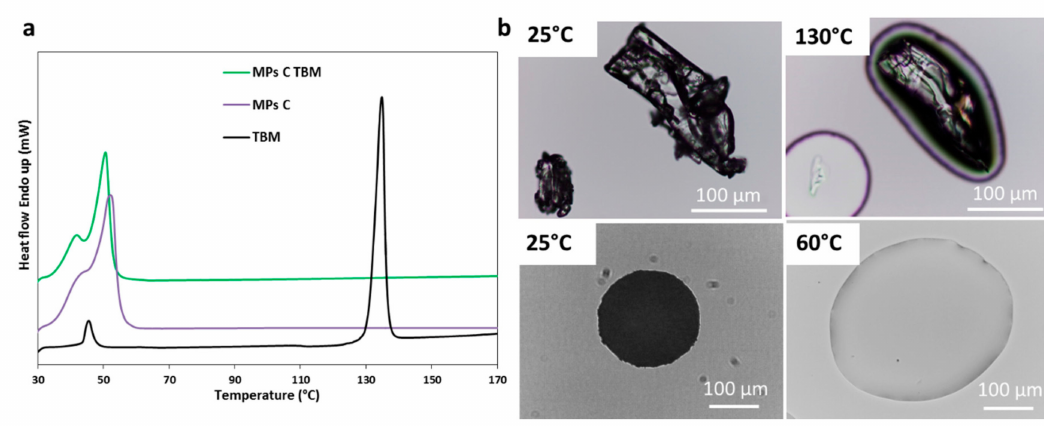
Figure 6. ( a ) DSC of TBM, unloaded MPs C, and MPs C TBM; ( b ) HSM images of TBM (on the top) and MPs C TBM (on the